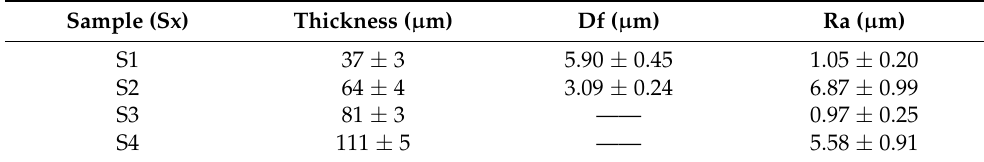
Table 3. Summary of coating thickness, average fiber diameter and surface roughness.